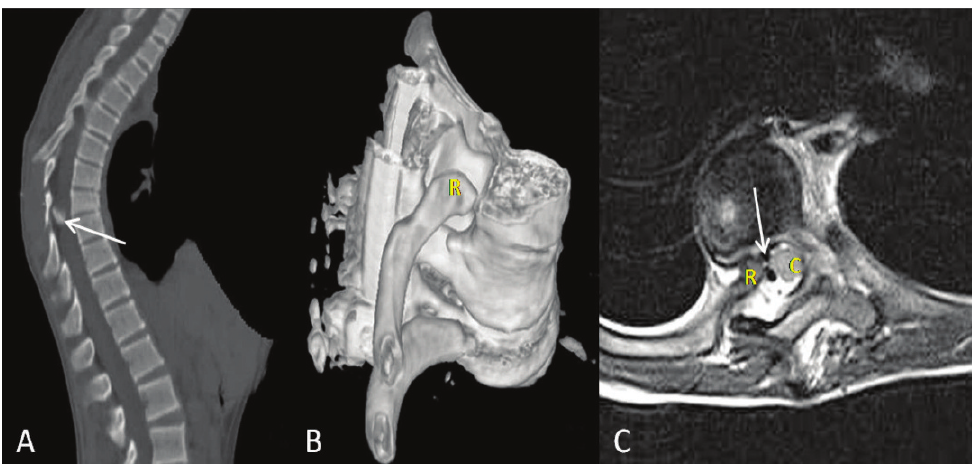
Figure 2 - Pre-operation radiology examination detected intra-canal rib head dislocation. A) Preoperative CT sagittal image showed the intra-canal portion of dislocated rib head (white arrow); B) 3D reconstruction image of the same patient showed rib head(R) dislocation into the canal; C) MRI demonstrated the intra-canal rib head(R) did not compress on the cord(C), and the boundary(white arrow) between the rib head and the cord was clear.